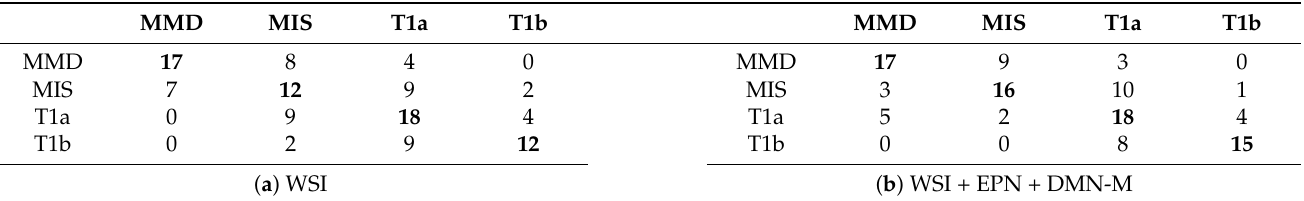
Table 4. Comparison of two confusion matrices. Rows are defined by expert consensus and columns are by model predictions. ( a ) An example experiment with only WSI and no segmentation mask.